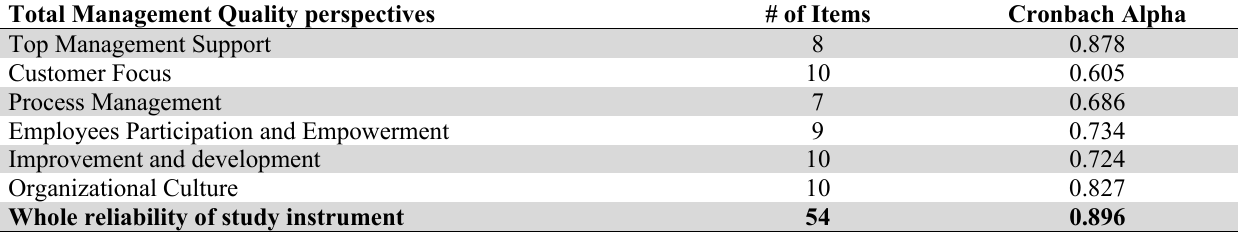
Internal reliability of study questionnaire Total Management Quality